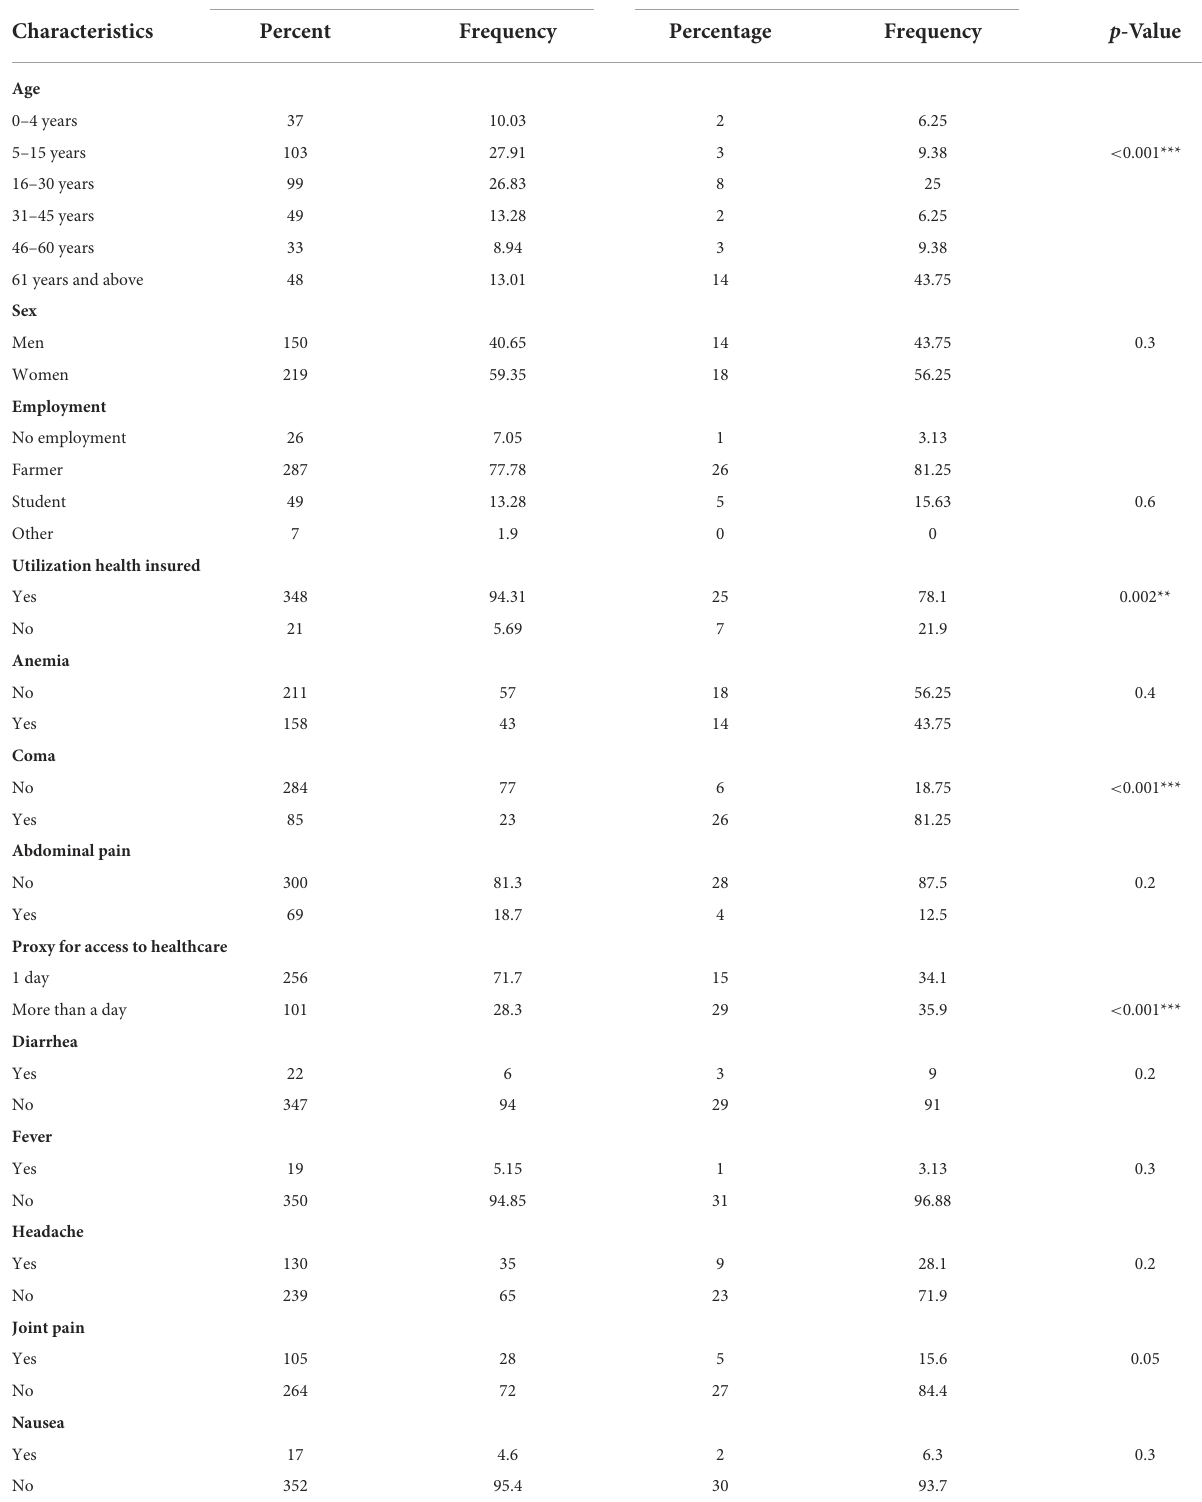
TABLE 2 Univariate analysis and number of deaths by socio-demographic and clinical characteristics. Survive Death Characteristics Percent Frequency Percentage Frequency p